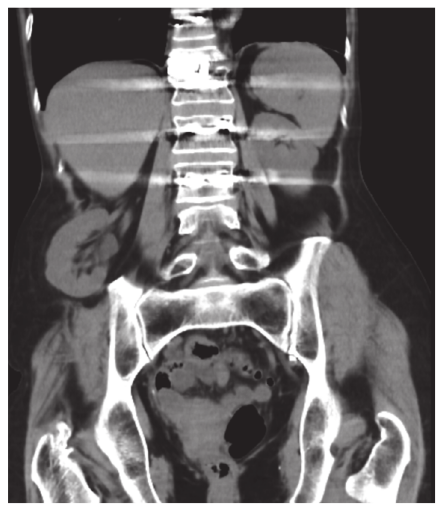
Figure 2: Coronal CT shows herniation of the right kidney immediately superior to the site of iliac crest bone harvest.